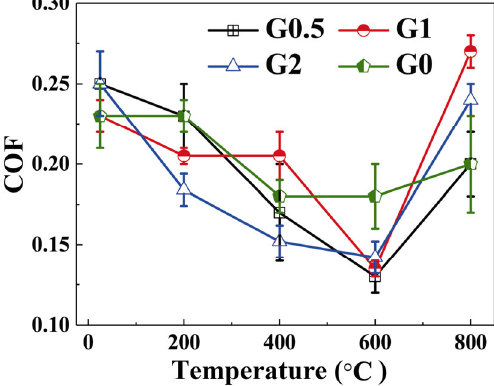
Fig. 4 Friction coefficient of nickel-alloy based composites as a function of